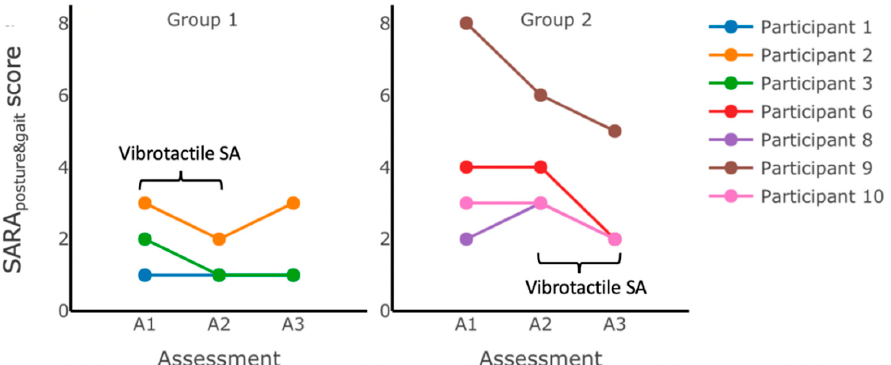
Figure 5. SARA posture&gait scores measured during assessments performed in the laboratory immedi- ately before (initial assessment A1), halfway through (intermediate assessment A2), and immedi-